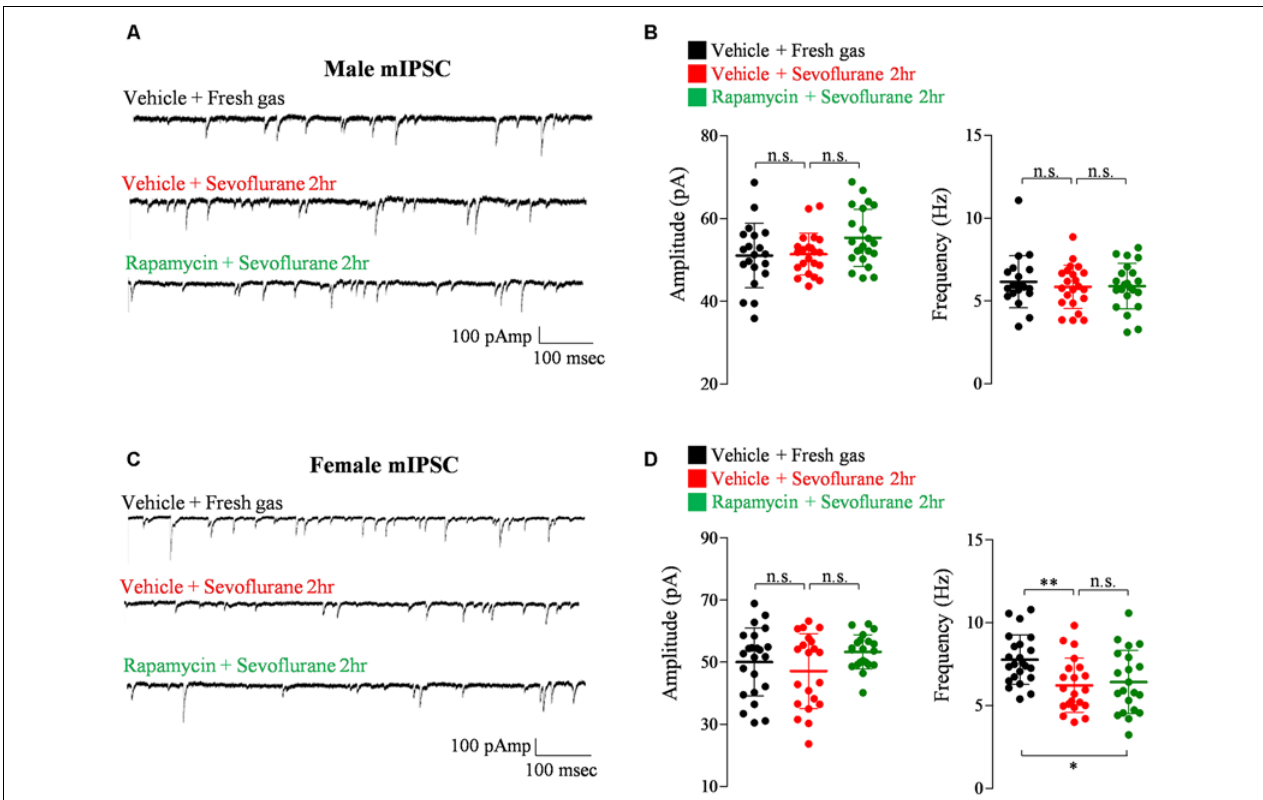
FIGURE 5 | Rapamycin does not prevent the decrease in inhibitory synaptic transmission in PND 16/17 female mice 24 h after sevoflurane exposure. (A,B) Frequency and amplitude of miniature inhibitory postsynaptic currents (mIPSCs) in male mice 24 h after sevoflurane exposure with/without rapamycin pretreatment (control: 20 cells from four mice; sevoflurane: 22 cells from four mice; rapamycin: 22 cells from four mice; n.s., not significant). (C,D) Frequency and amplitude of mIPSC in female mice 24 h after sevoflurane exposure with/without rapamycin pretreatment (control: 23 cells from four mice; sevoflurane: 21 cells from four mice; rapamycin: 21 cells from four mice; n.s., not significant, ∗ p < 0.05, ∗∗ p <